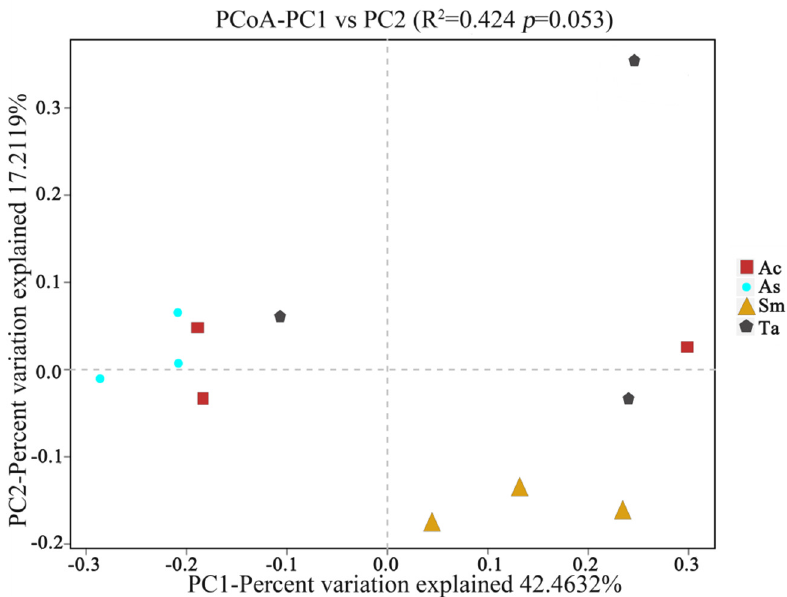
Figure 2. Principal coordinate analysis (PCoA) between four species of grasshoppers. Ac: red rectangle; As: blue circle; Sm: yellow triangle; Ta: gray polygon. The horizontal and vertical coordinates are the two eigenvalues that cause the largest difference between samples, and the main influence degree is reflected in the form of percentage. Ac, Acridia chinensis ; As, Atractomorpha sinensis ; Sm, Sphingonotus mongolicus ; Ta, Trilophidia annulate .